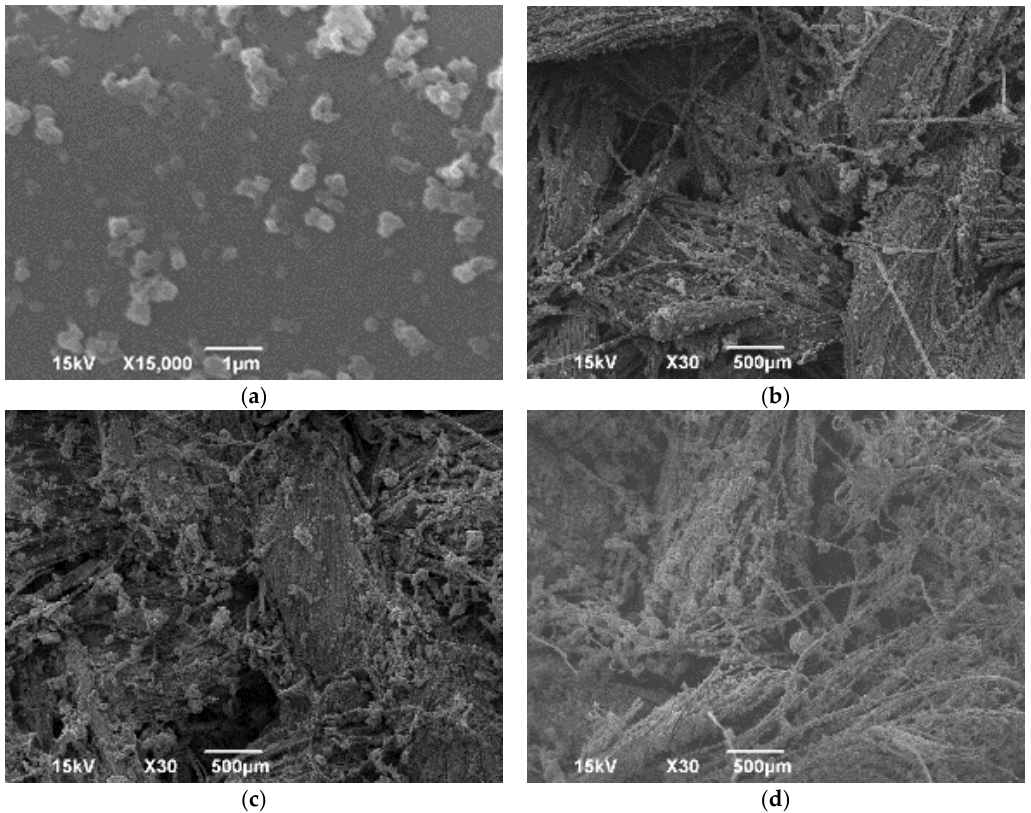
Figure 12. SEM images of ( a ) nanosilica particle agglomerates, ( b ) 30% STF flax, ( c ) 50% STF flax, ( d ) 70% STF flax.